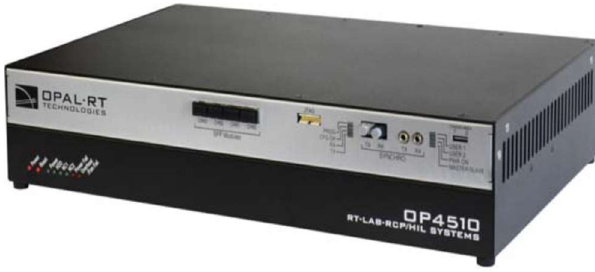
Figure 25. OPAL-Real Time Hardware-In-the-Loop (HIL) located in the authors’ lab.